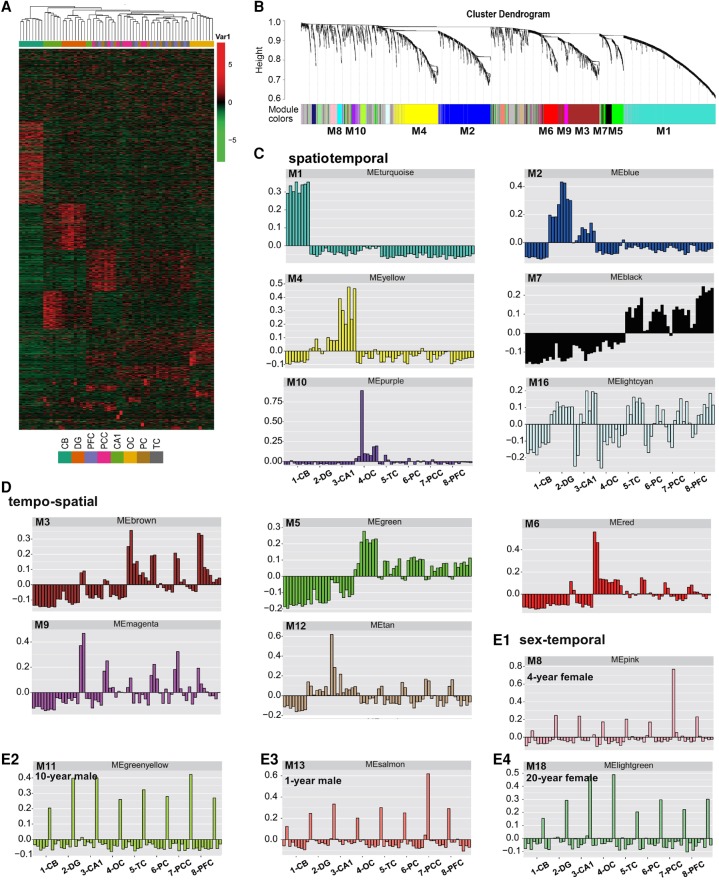
The discrete expression modules of lncRNA expression by the WGCNA analysis. (A) Hierarchical clustering heat map of all differentially expressed lncRNAs (Fig. 2C, right) by samples. LncRNA modules were arranged from 0 (top) to 18 (bottom). (B) Hierarchical cluster dendrogram of all differentially expressed lncRNAs modules. Modules corresponding to branches are labeled with colors indicated by the color bands underneath the tree. (C) Eigengene bar plot of spatiotemporal modules of lncRNAs. Samples were first sorted by brain regions in the order of CB, DG, CA1, OC, TC, PC, PCC, and PFC. In each brain region, samples were then sorted by age (1 yr to 20 yr), and by sex (female and male). (D) Eigengene bar plot of tempo-spatial modules of lncRNAs in the same sample order as in C. (E1–E4) Eigengene bar plot of sex-temporal modules of lncRNAs in the same sample order as in C.